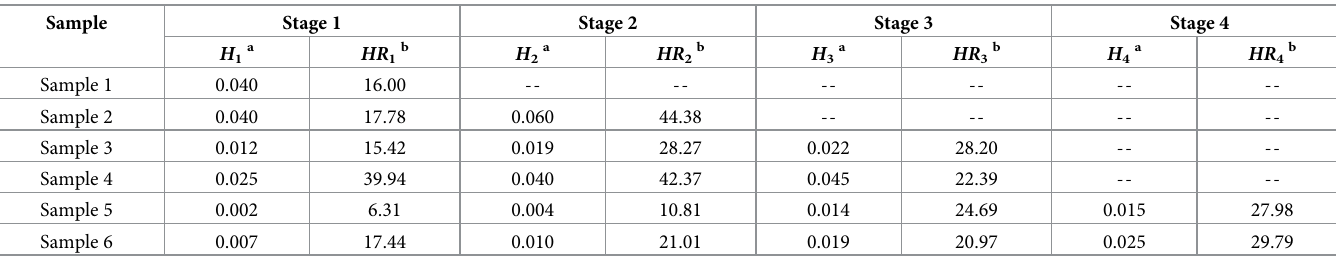
Table 6. Creep deformation and ratio in the four reduction stages for each soil sample.